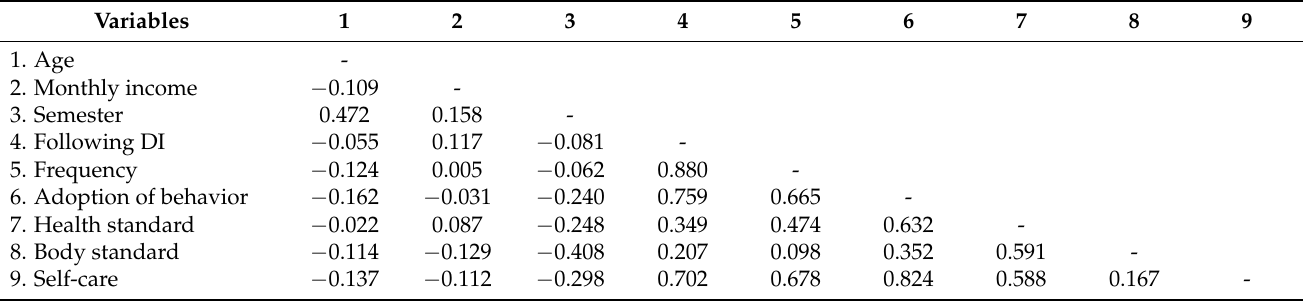
Table 4. Weight matrix for the associations between the network variables for